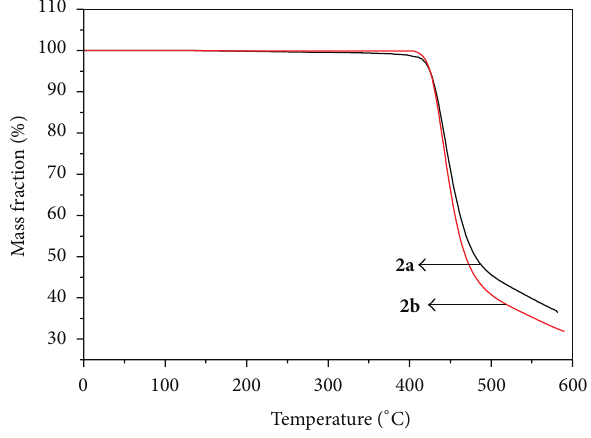
Figure 3: TGA curves of polymers 2 .